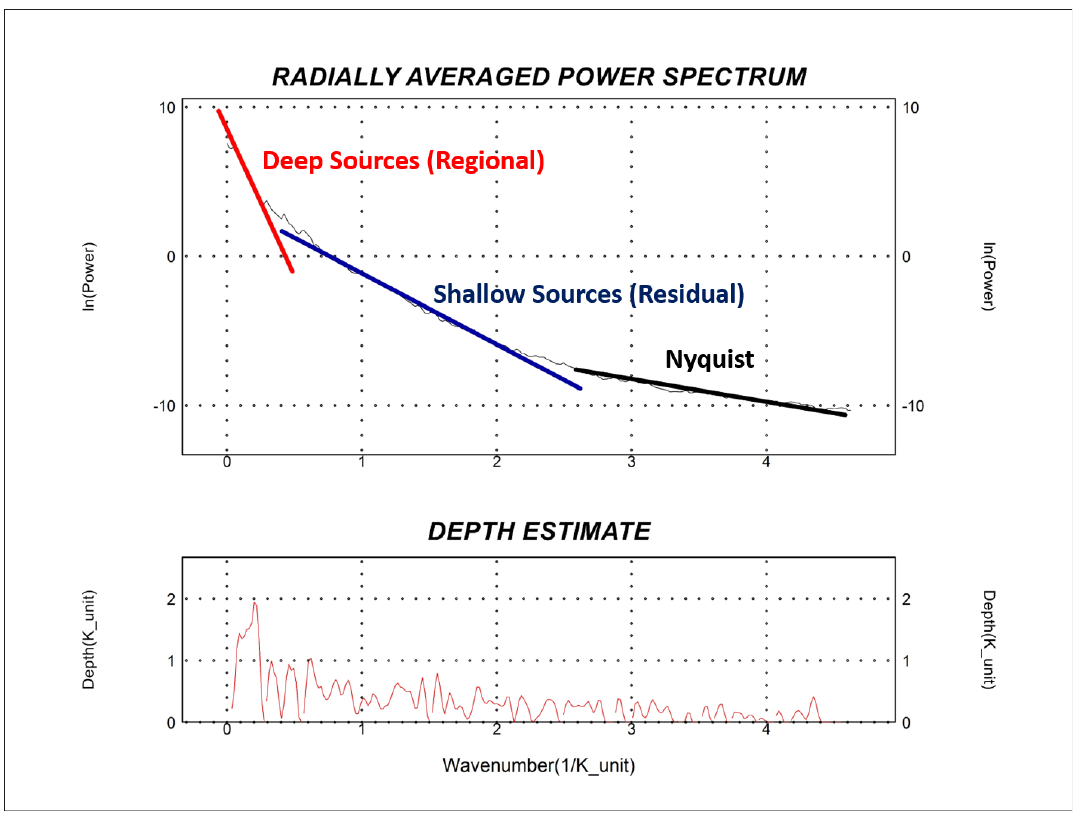
Figure 4. The research region ’ s radially-averaged power spectrum as calculated from the RTP magnetic data.